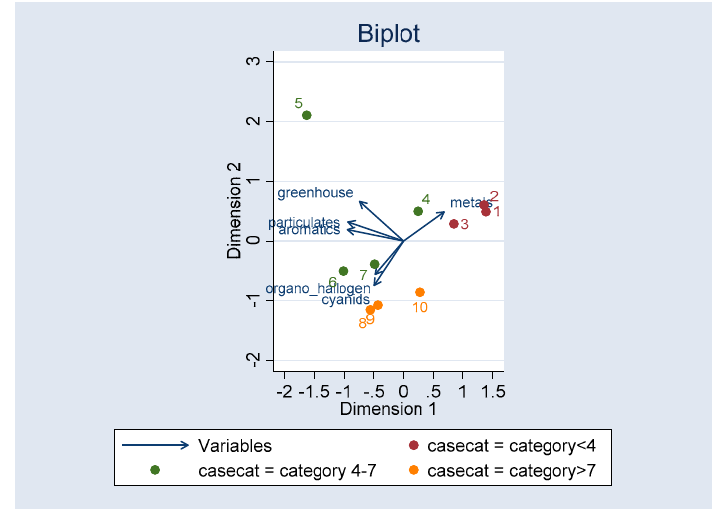
Figure 8. Clustering of cases by pollutant categories.